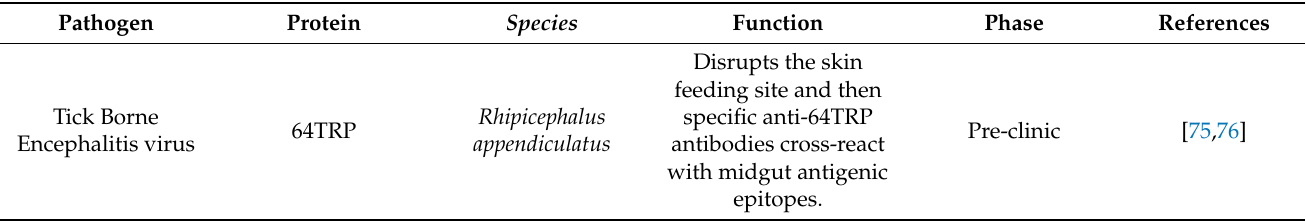
Table 3. List of salivary proteins studied as potential vaccine candidates. Pathogen Protein Species